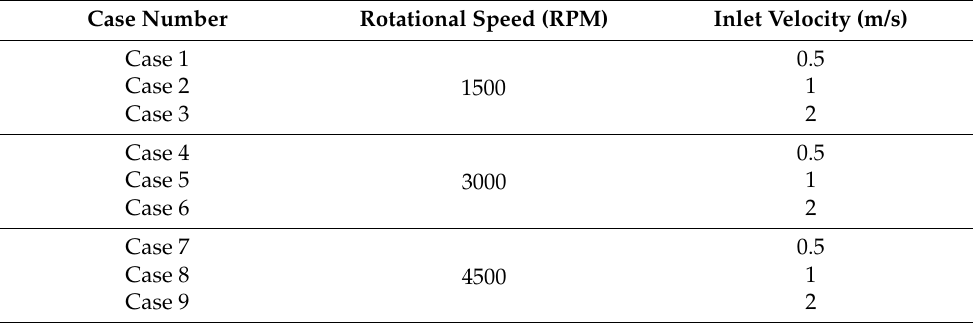
Table 2. Operating